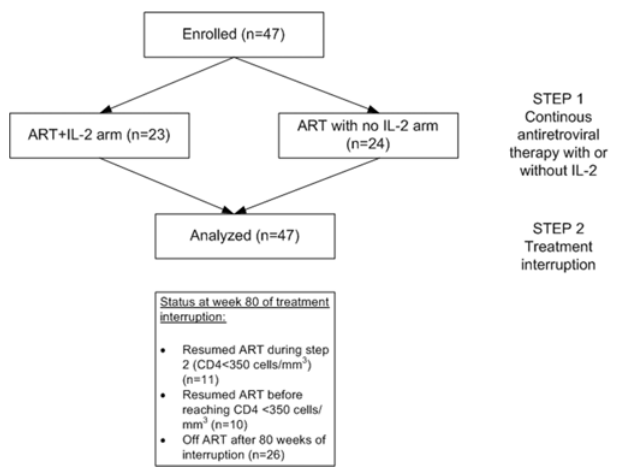
Figure 1. Consort diagram. All patients were included in the analysis and censored after the re-initiation of antiretroviral therapy during Step